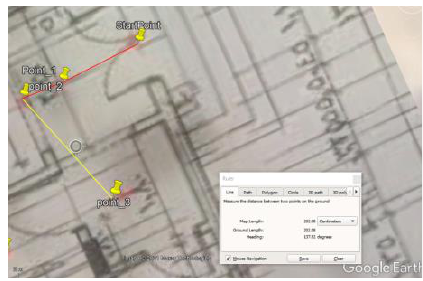
Figure 29. Length and heading to point_2.